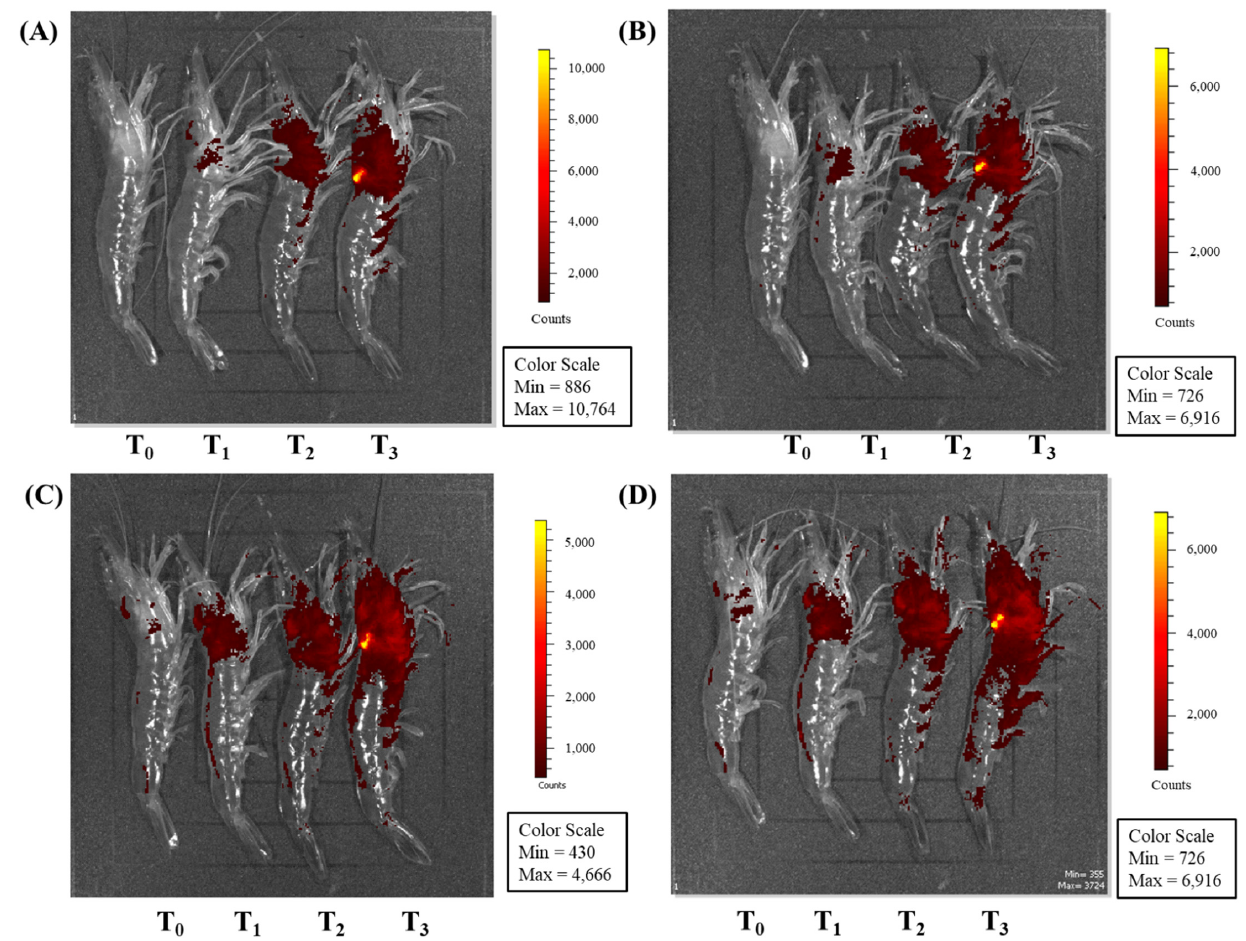
Figure 6. Visualization of whiteleg shrimp after injections of different doses of phycoerythrin. The whiteleg shrimp were observed under an in vivo imaging system (IVIS) at 2 ( A ), 4 ( B ), 6 ( C ), and 8 ( D ) hours post-injection with 0, (T 0 ; control), 0.08 (T 1 ), 0.15 (T 2 ) and 0.30 (T 3 ) μ g phycoerythrin per gram of whiteleg shrimp body weight.